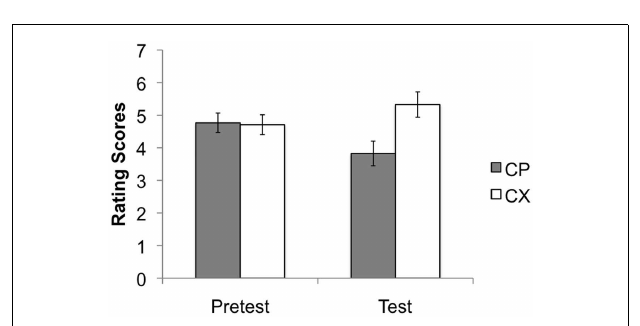
FIGURE 4 | Mean rating scores for the key comparison stimulus compounds CP and CX during the pre-test and test stages . A rating of 9 reflects expectation of a positive image, 1 of a neutral image, and 5 uncertainty; 95% confidence intervals are presented.The stimulus compounds elicited similar ratings prior to conditioning, but the test ratings confirmed the presence of conditioned inhibition, evident as lower ratings to CP than to